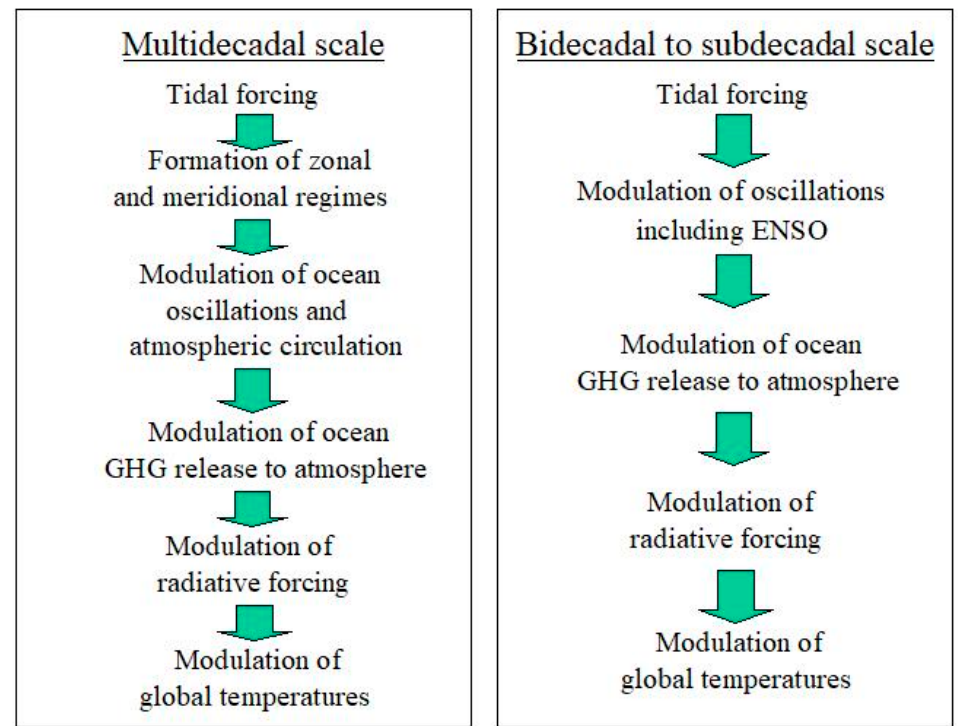
Figure 12. Schematic diagram of suggested steps linking tidal forcing to global climate effects.